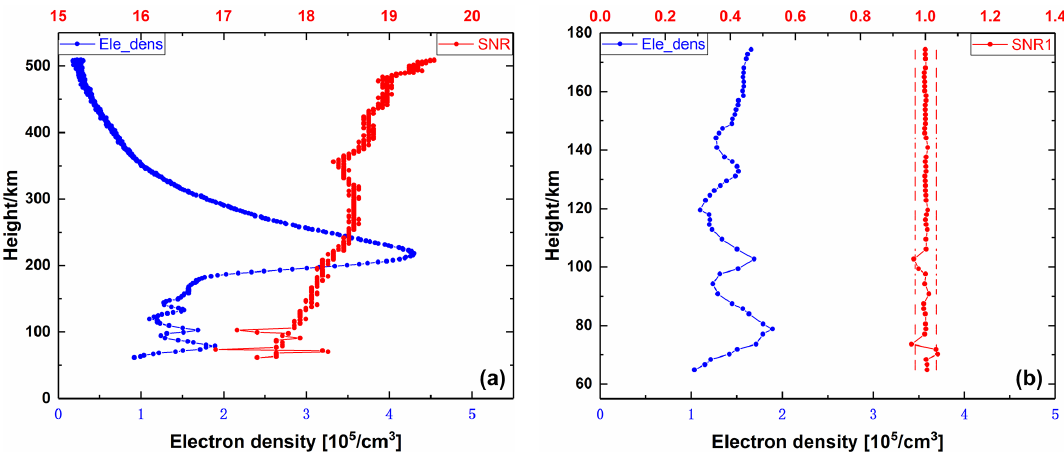
Figure 2. Schematic diagram of G17 multi-layer E s sounding. Panel (a) shows the electron density profile of the G17 occultation event and the SNR profile at 20:58GPST on 27 August 2018. Panel (b) shows the electron density profile and normalized SNR profile within 60–160km at the same time, and the red dotted line is the SNR1 ± 3std boundary